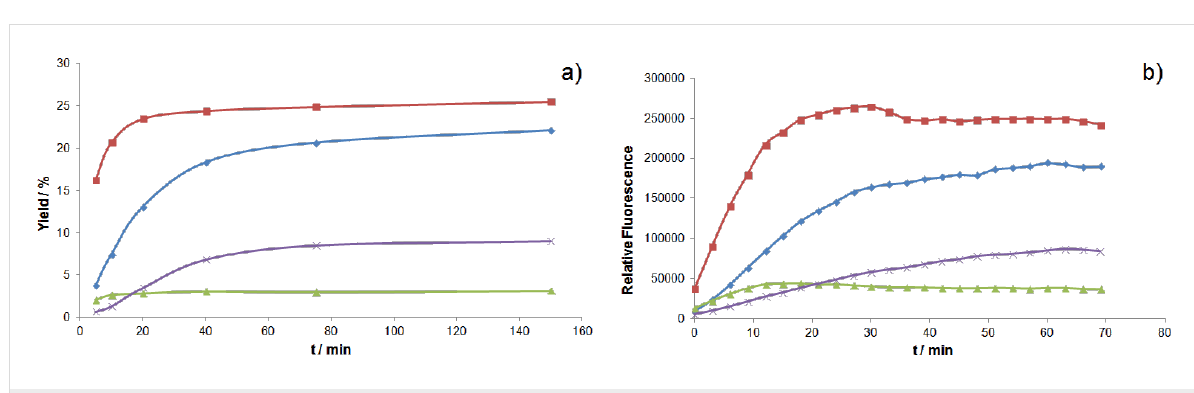
Figure 4: Comparison of kinetics measured by HPLC a) and by a plate reader b) for the ring-closing metathesis of 8 in acetic acid.